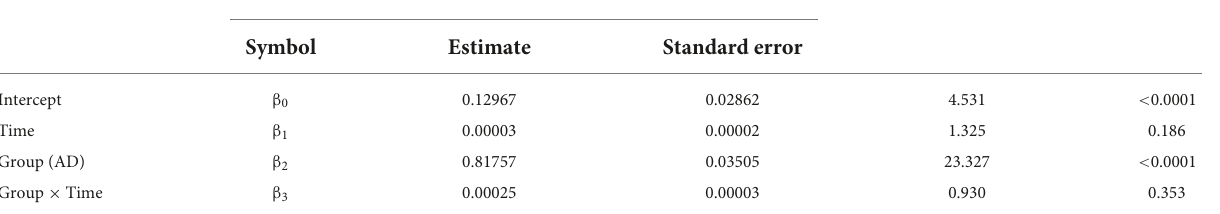
TABLE 5 Estimated coefficients based on LME model for the AD-RAI.